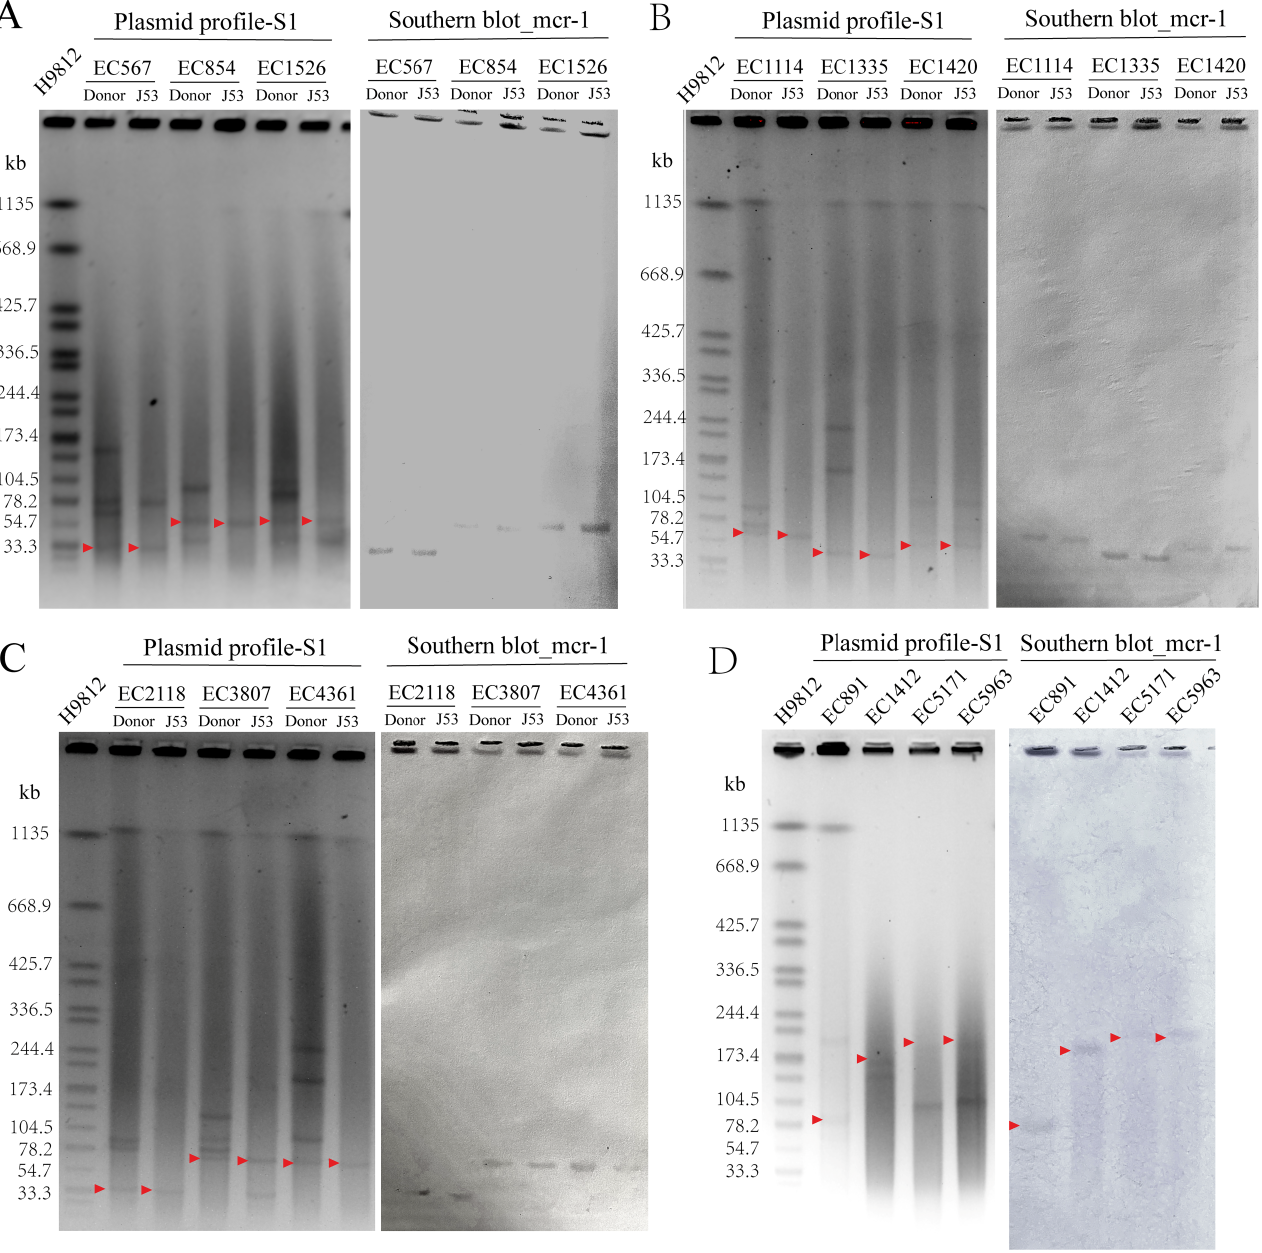
Figure 3. S1-PFGE and southern blotting for investigating plasmids containing mcr -1. MCREC isolates carrying conjugative mcr -1 plasmids were examined in panels ( A – C ). ( D ) Analysis of the four MCREC isolates that carrying nonconjugative mcr-1 plasmids. The Salmonella strain (H9812) was used as a marker. Red arrows represent the mcr-1 -carrying plasmids.